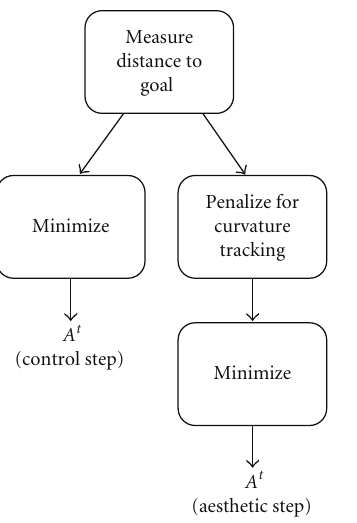
Figure 1: Control versus aesthetic